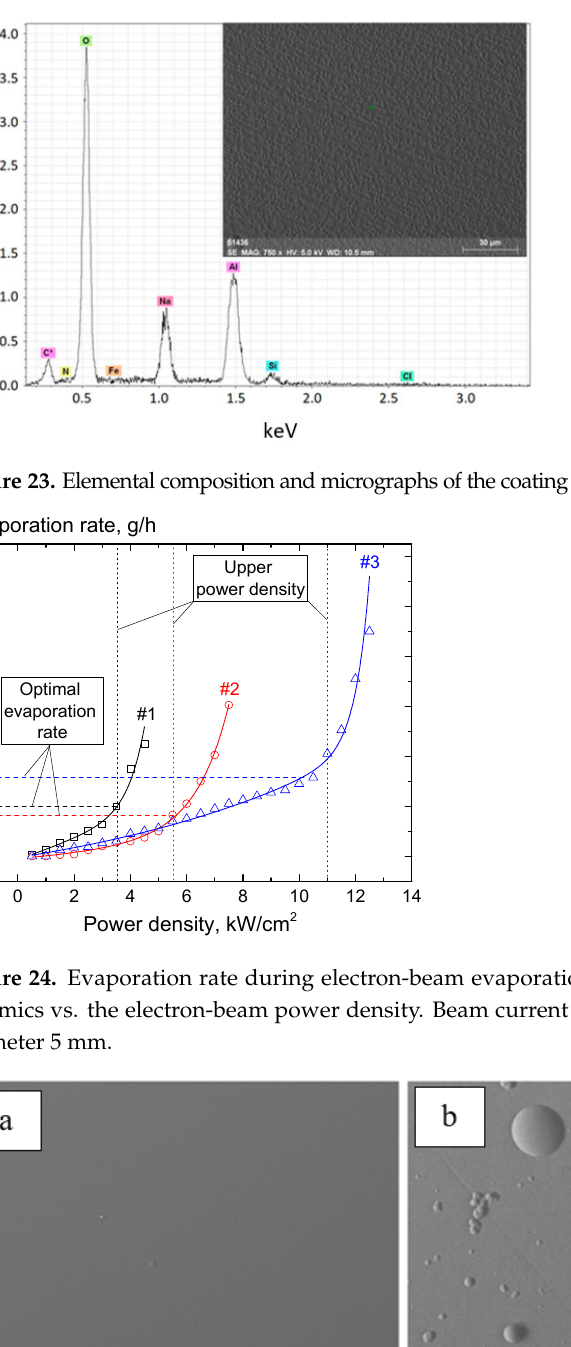
Figure 23. Elemental composition and micrographs of the coating deposited on a titanium sub- strate [134].